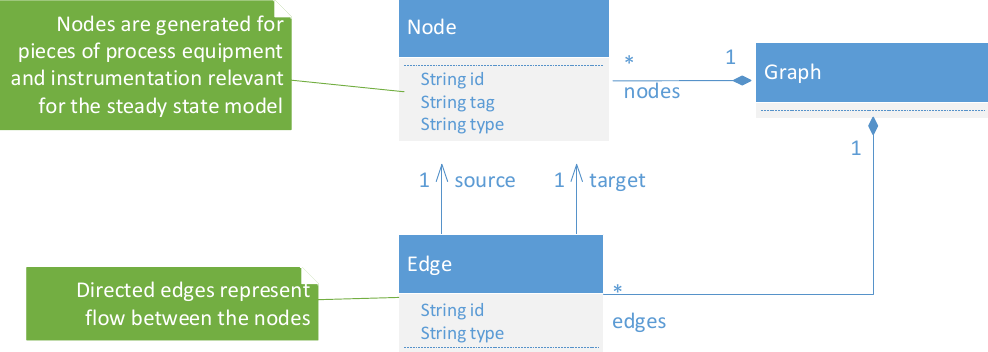
Figure 2. UML class diagram of the graph representation of the information extracted from the digitalized P&ID.